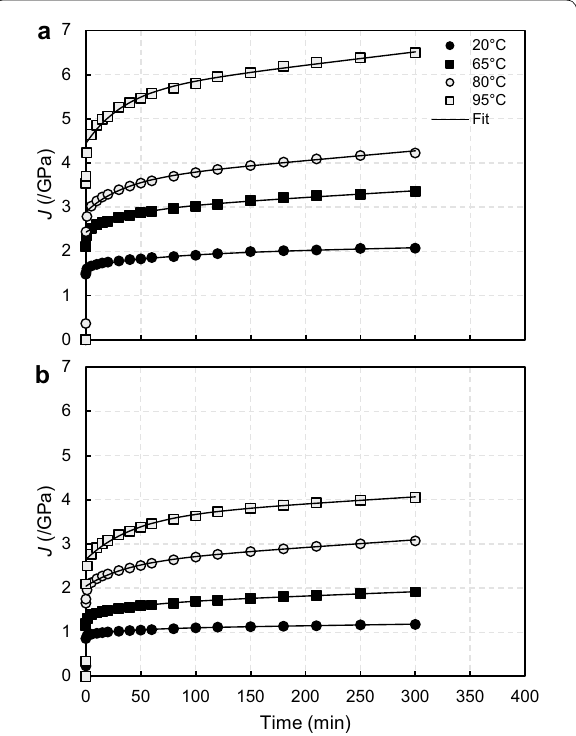
Fig. 4 Surface strain and free-end deflection of sugi boxed-heart timber at each temperature. a Surface-layer specimen; b inner-layer specimen